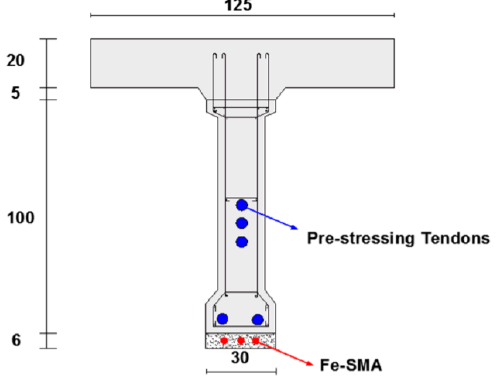
Figure 8. Cross section of the case studied girder (units are in cm) [60].